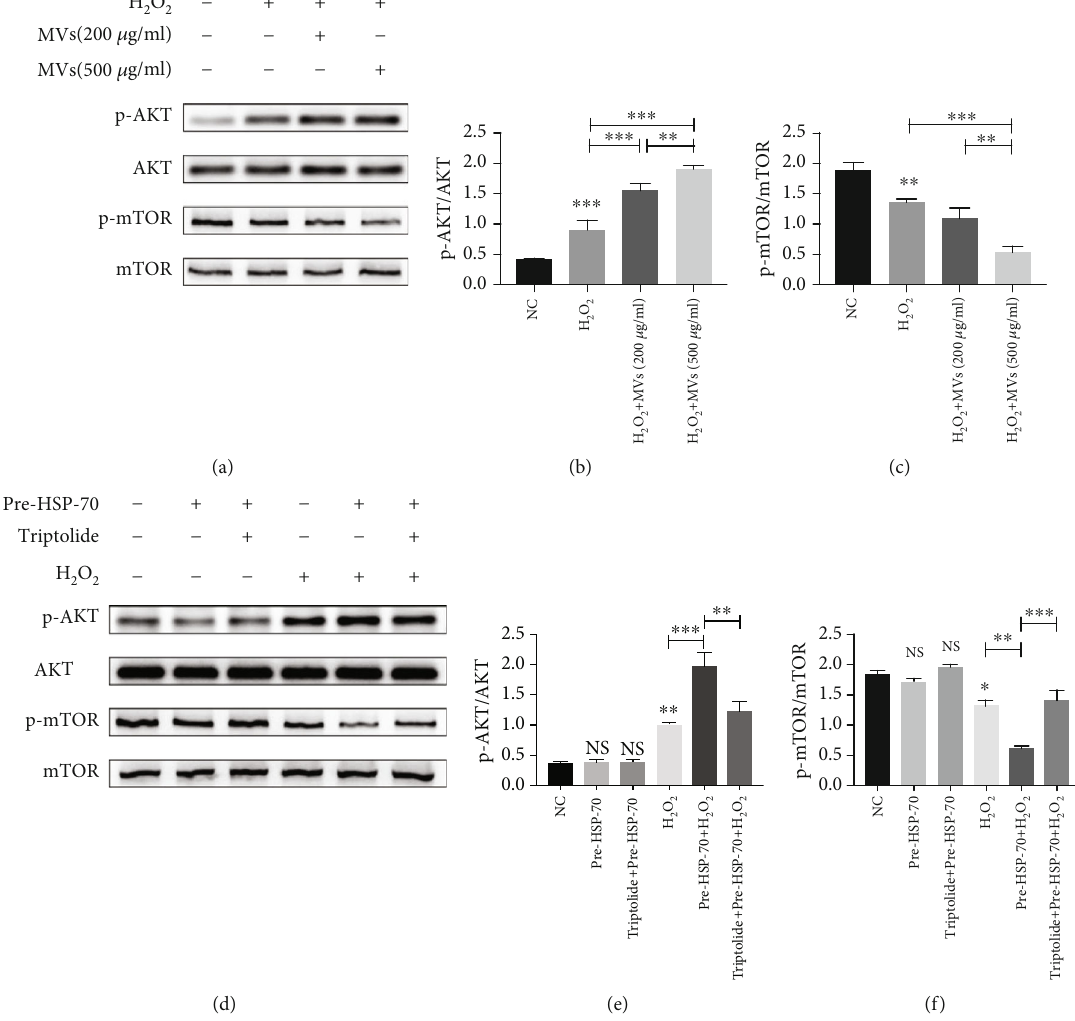
O stimulation. (a – f) Representative 2 2